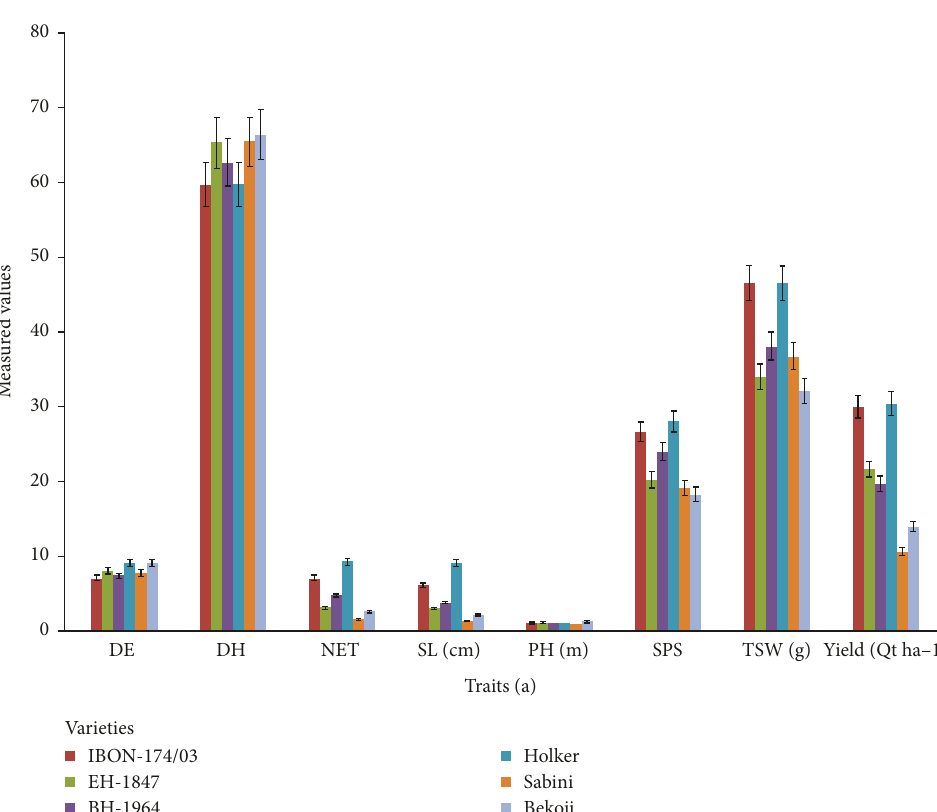
Figure 6: Mean performance of malt barley varieties in 2019 cropping season. DE � days to an emergency, DH � days to heading, NET � number of effective tillers per plant, SL � spike length, PH � plant height, SPS � seeds per spike, and TSW � thousand seed